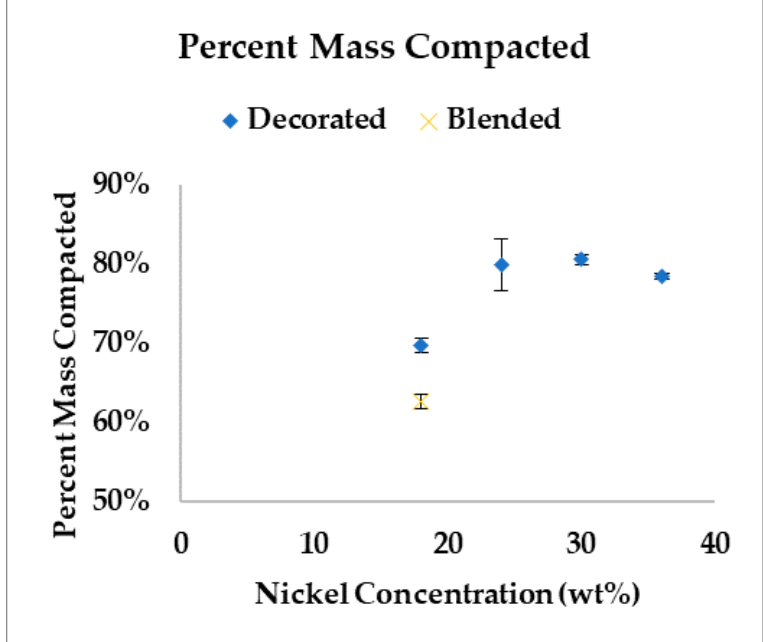
Figure 2. Percent mass compacted during impact testing. Error bars indicate + 1 standard deviation.